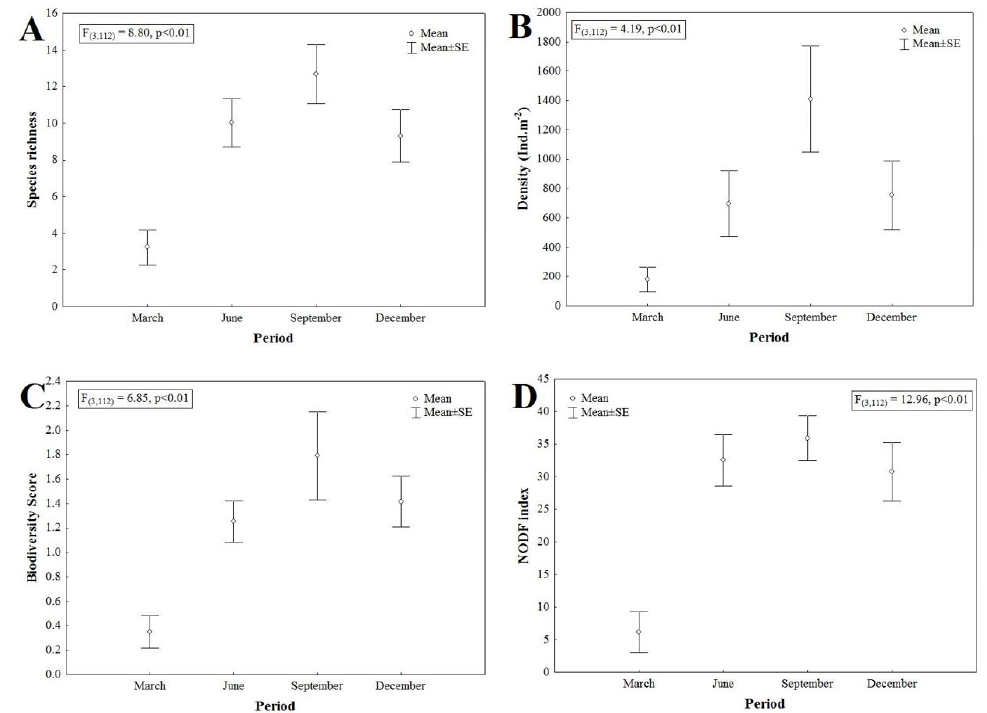
Figure 6. Variations in Chironomidae community in each sampled period according to the mean and standard error (SE) of (A) species richness; (B) density; (C) Biodiversity score; and (D) NODF index. Table 1. Results of Spearman’s correlation between the gradients of environmental heterogeneity with Chironomidae community attributes.